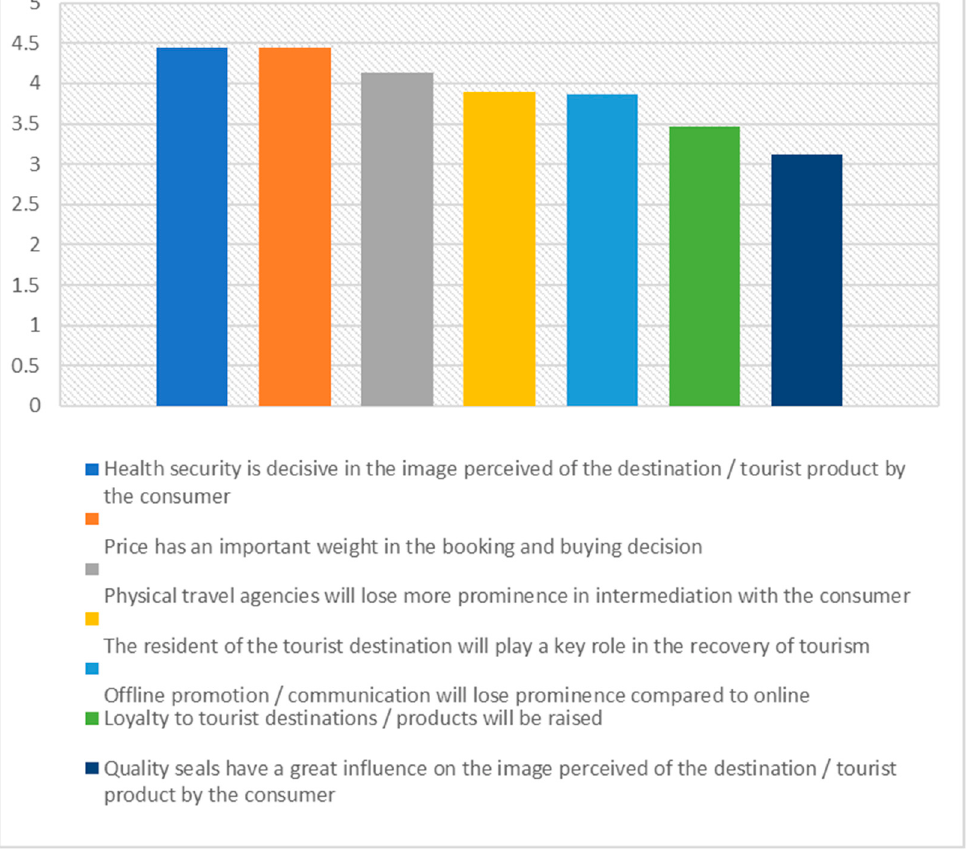
Figure 4. Post ‐ pandemic tourism expectations (Likert scale from 1 to 5). Figure 4. Post-pandemic tourism expectations (Likert scale from 1 to